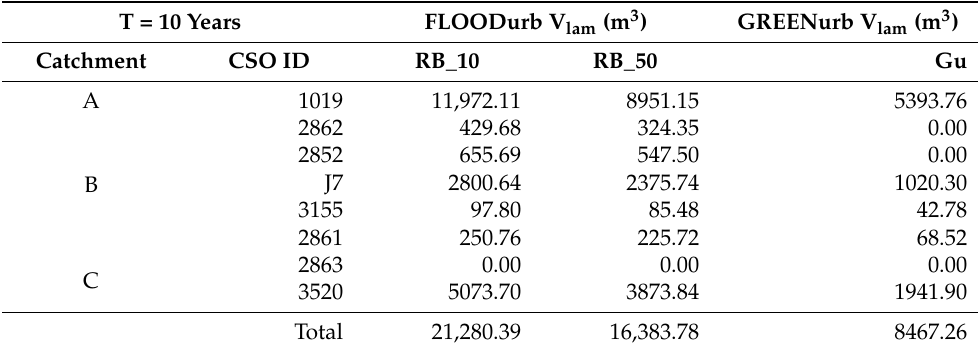
Table 7. Stormwater detention tanks volumes in the hybrid scenario for a 10-year return-period